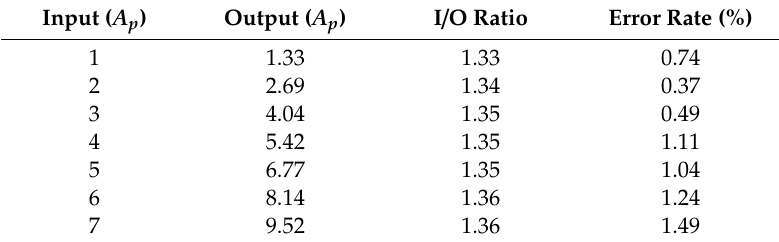
Table 2. Verification result for current amplifier. Table 3. Verification result for voltage amplifier.